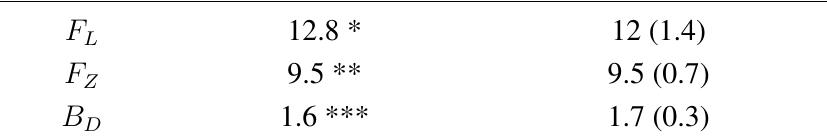
Table 1. Experimental and theoretical sound beam parameters for Panametrics V303. The experimental values have been determined from Figure 5. The standard deviations are given in